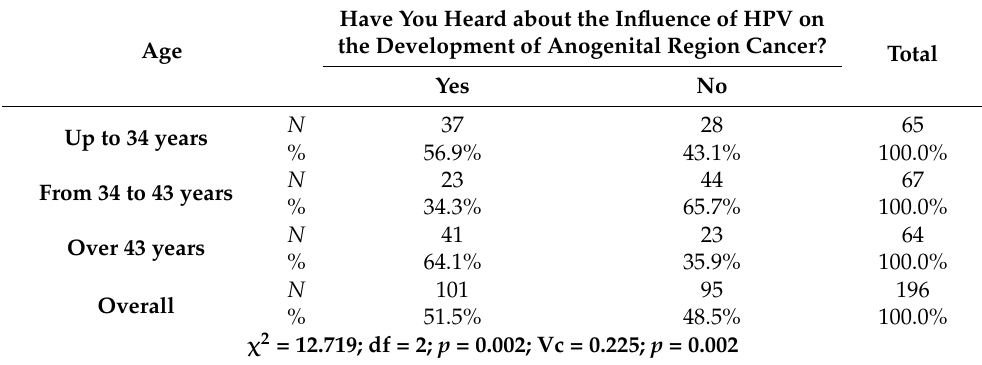
Table 4. Results from analyzing the relationship between the age of the respondents and the awareness of the influence of HPV on the development of anogenital region cancer. Have You Heard about the Influence of HPV on the Development of Anogenital Region Cancer? Total Age Yes No N 37 28 65 Up to 34 years % 56.9% 43.1% 100.0% N 23 44 67 From 34 to 43 years % 34.3% 65.7% 100.0% N 41 23 64 Over 43 years % 64.1% 35.9% 100.0% 101 95 196 Overall 51.5%